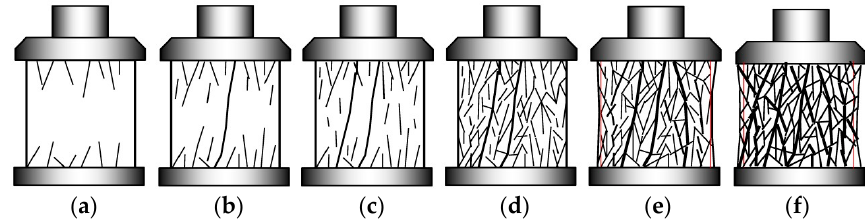
Figure 19. Schematic sketch of the ice fracture mode at moderate strain rates: ( a ) cracks emerge; ( b ) cracks propagate vertically or approximately vertically; ( c ) several vertical full-height cracks appear; ( d ) forming quantities of intersection and link-up among cracks, and reaching peak load; ( e ) expanding obviously; and ( f ) crushing into small fragments.